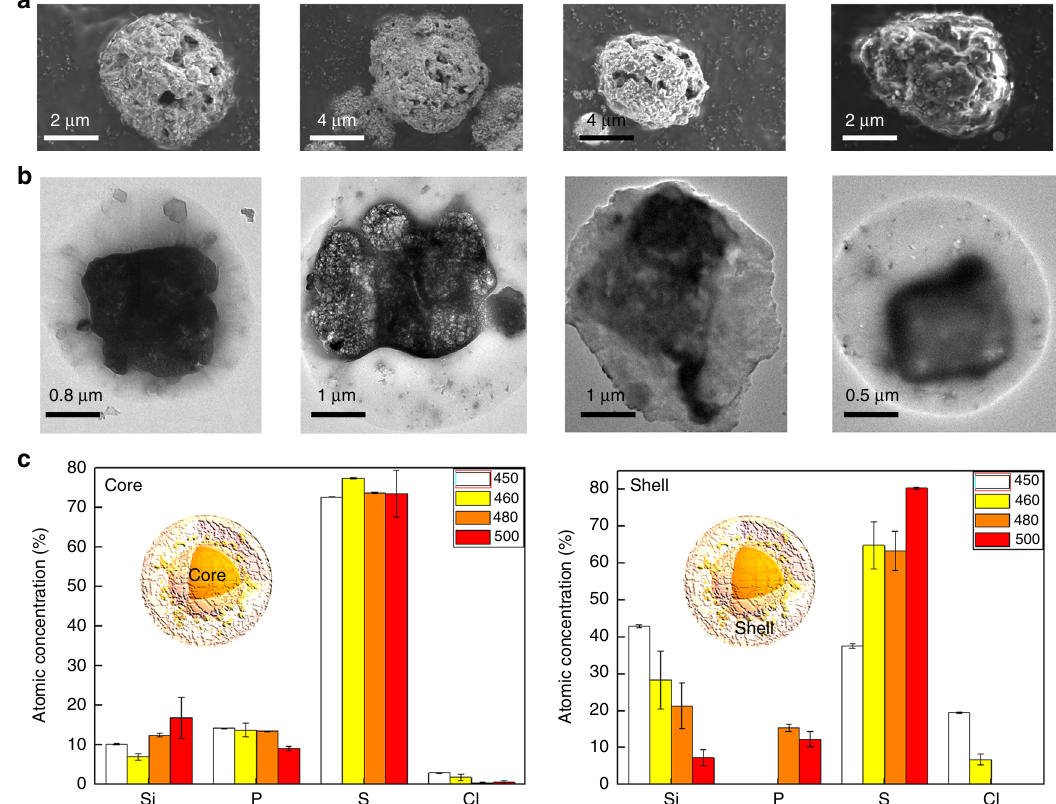
Fig. 2 Microstructural study on the morphology and composition of LSPS-Cl powders annealed at 450, 460, 480, and 500 °C. a SEM and b TEM images show their typical core-shell structures. c STEM EDS analyses of these samples show a continuously decreasing Si concentration and increasing S concentration in the shell of these samples versus the increasing annealing temperature